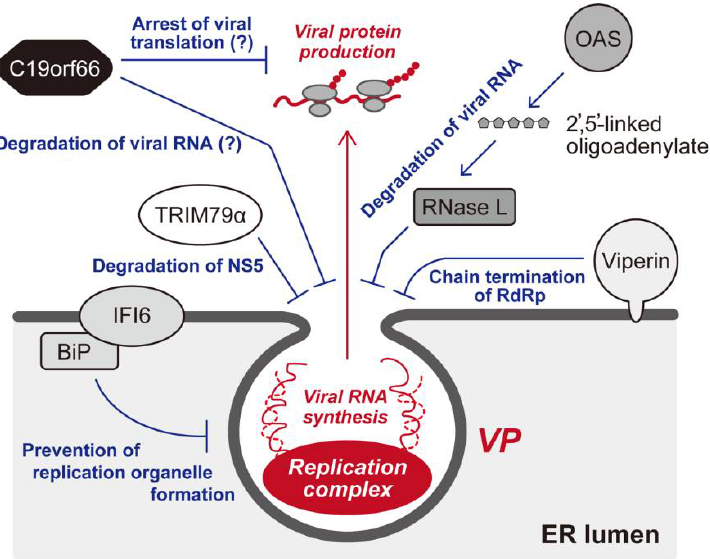
Figure 2. IFN-inducible cellular factors targeting flavivirus replication complex. Several ISGs that are reported to inhibit the activity of membrane-associated replication complex are shown. Recognition of virus-specific dsRNA by OAS produces 2′,5′-linked oligoadenylate, resulting in the activation of RNase L, which in turn degrades viral RNA. Viperin, an ER-associated antiviral ISG, catalyzes the synthesis of ddCTP, which is likely to act as a chain terminator for the flaviviral NS5 RdRp. IFI6 is also shown to be associated with ER, and this ISG is reported to prevent the formation of a replication organelle via interaction with BiP. TBEV replication is shown to be inhibited by TRIM79α, which appears to promote the lysosomal degradation of NS5. C19orf66 (aka RyDEN, IRAV, or Shiftless) is a recently identified ISG that is capable of suppressing the replication of various types of RNA and DNA viruses. As for DENV infection, two modes of inhibition of C19orf66 have been proposed: translational suppression and/or degradation of viral RNA.